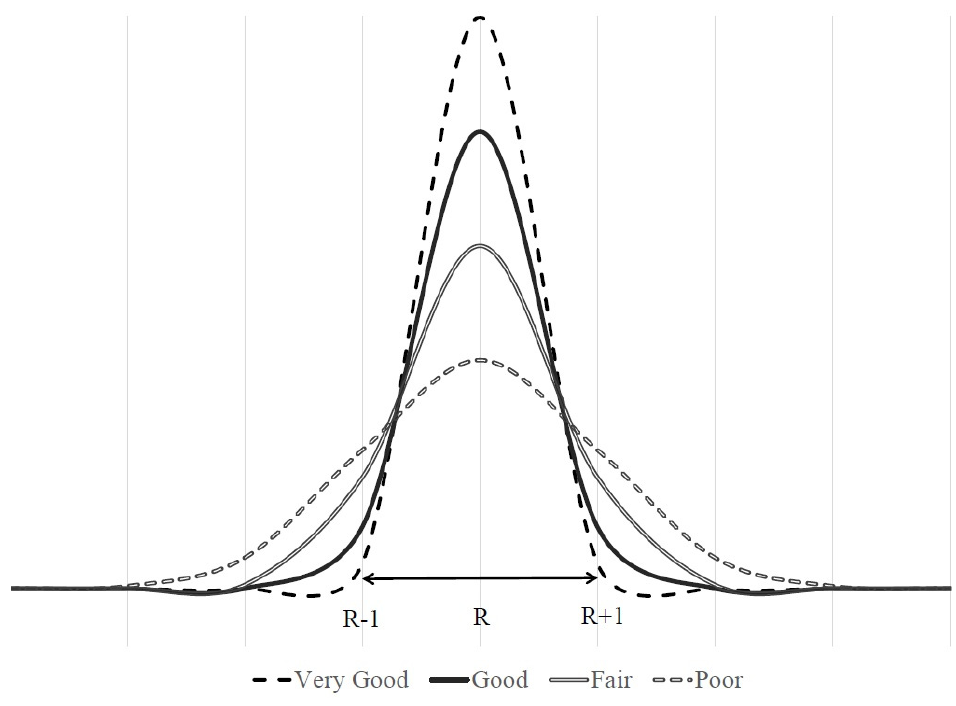
Figure 11. Accuracy Levels of NDE methods.